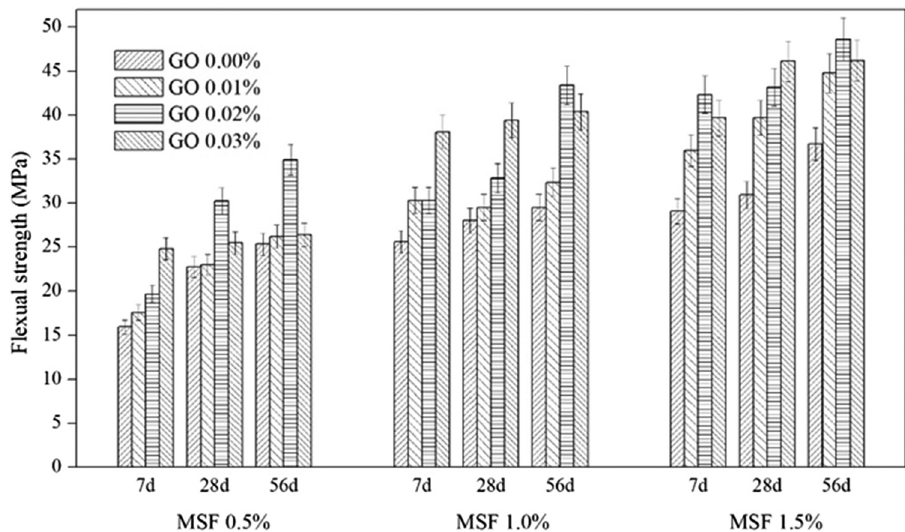
Figure 7: Flexural strength of UHPC under standard